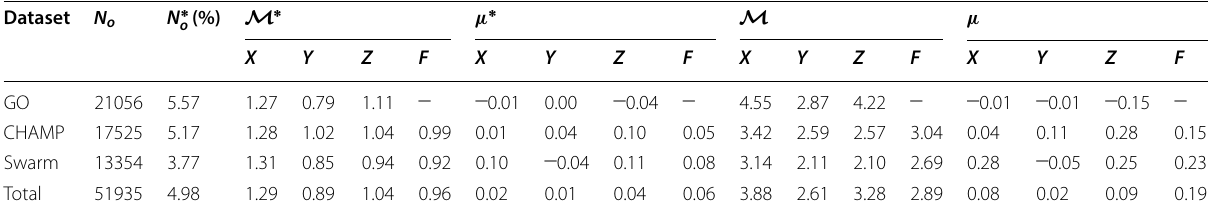
Dimensional misfits and biases are in units of nT for VOs, and nT/year for GO